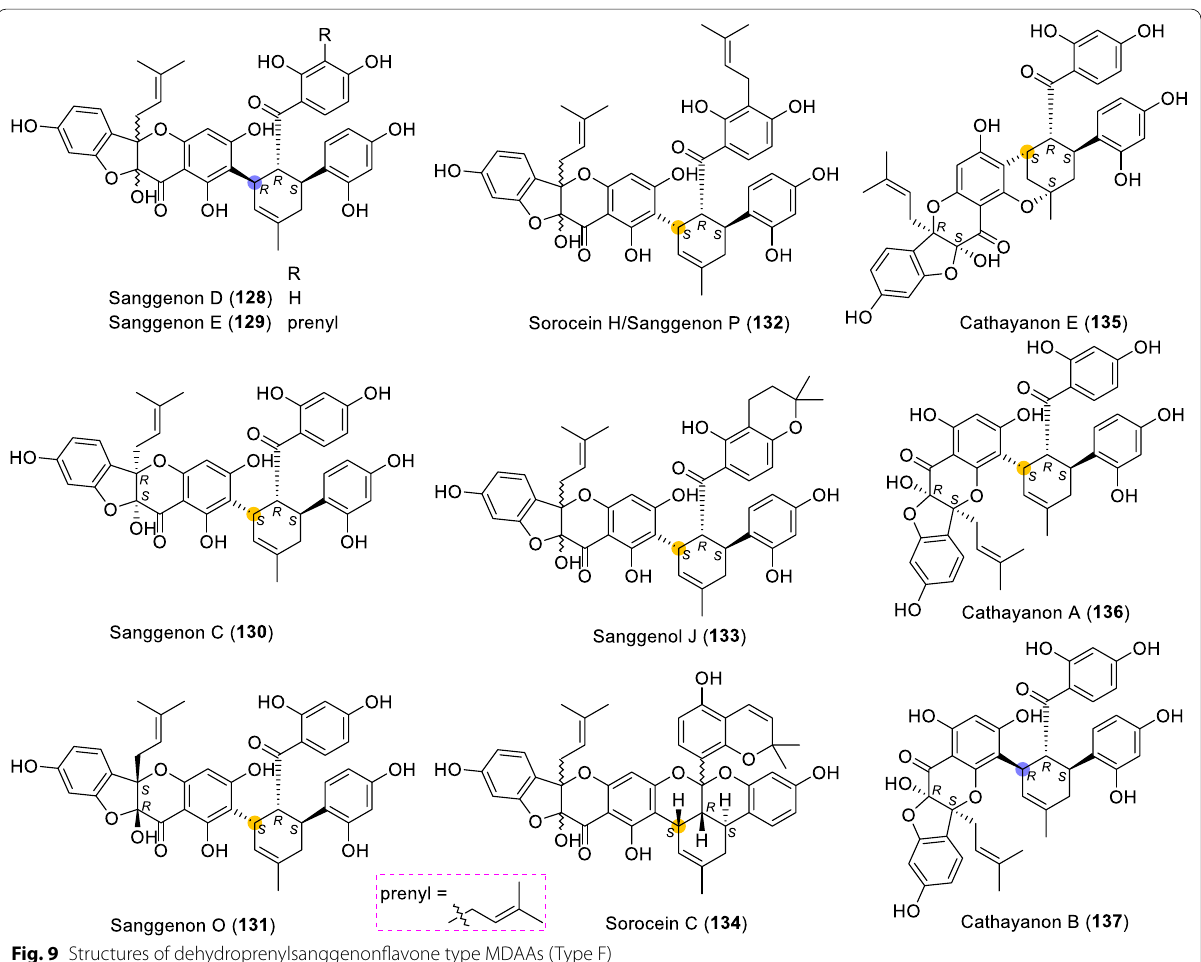
Fig. 9 Structures of dehydroprenylsanggenonflavone type MDAAs (Type